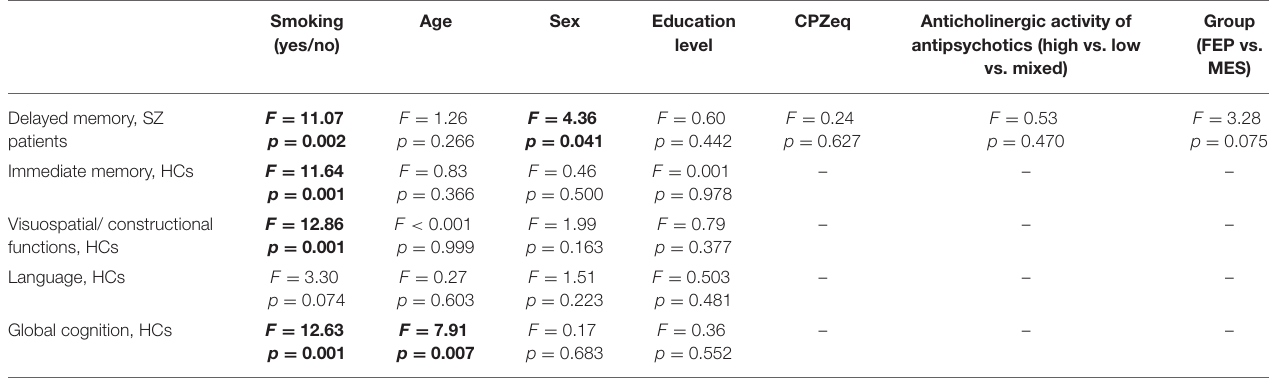
Smoking Age Sex Education (yes/no)